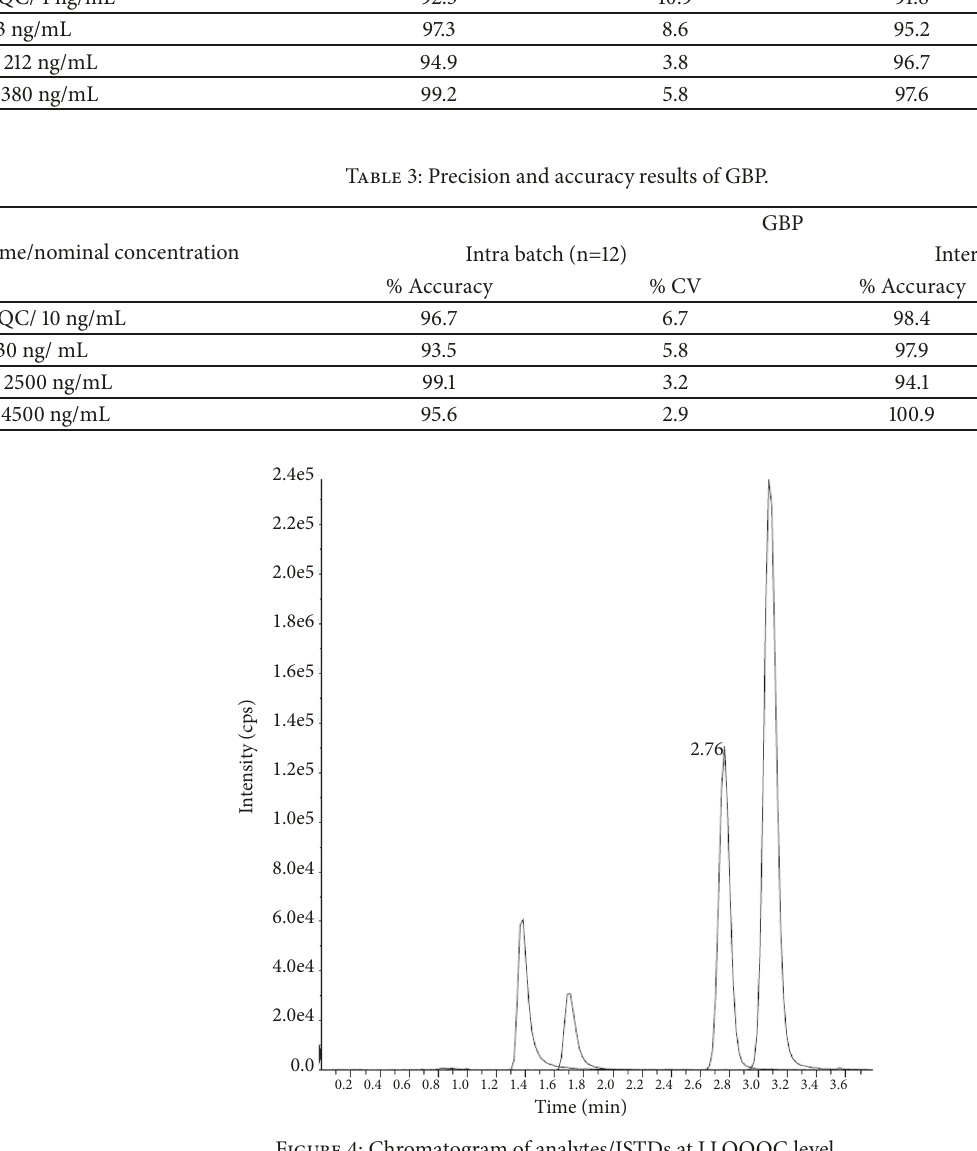
Figure 4: Chromatogram of analytes/ISTDs at LLOQQC